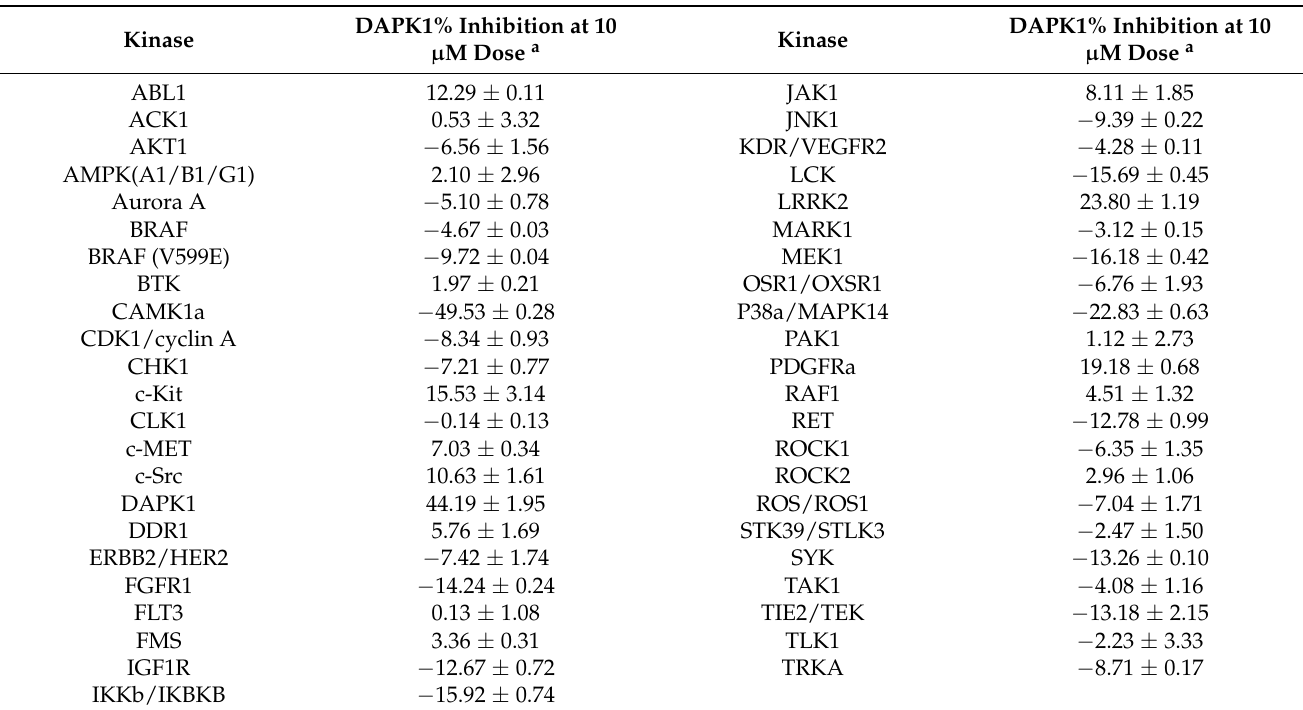
Table 2. % enzyme inhibition (relative to DMSO controls) of compound 4a in a single-dose duplicate mode assay at a concentration of 10 µ M against 45